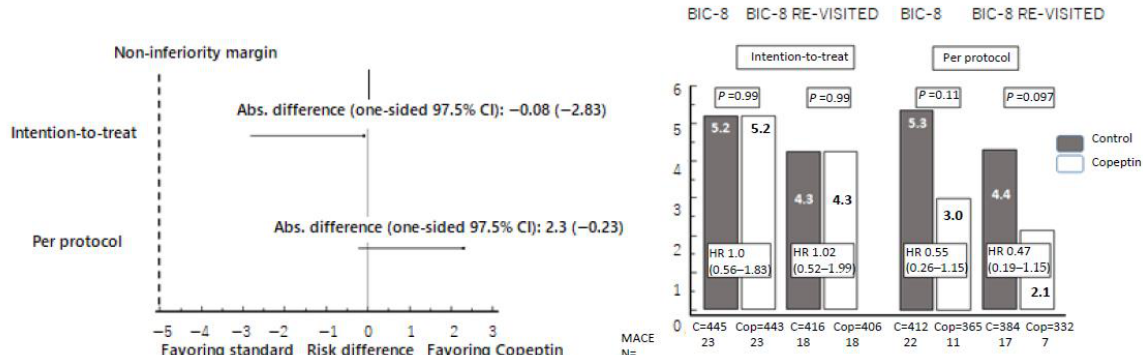
Figure 2. Left panel: Forest plot for differences in major adverse cardiac event (MACE) proportions. Absolute differences in MACE proportions within 30 days between the study groups with one-sided 97.5% CIs. The non-inferiority margin was prospectively defined at 5%. In none of the performed analyses, the non-inferiority margin was exceeded. Right panel: Proportions of MACE and corresponding hazard ratios (HR) with 95% confidence intervals (95% CI) according to intention-to-treat (including per protocol and protocol deviations), or per protocol treatment, both in the original BIC-8 trial and in the secondary analysis (BIC-8 RE-VISITED).